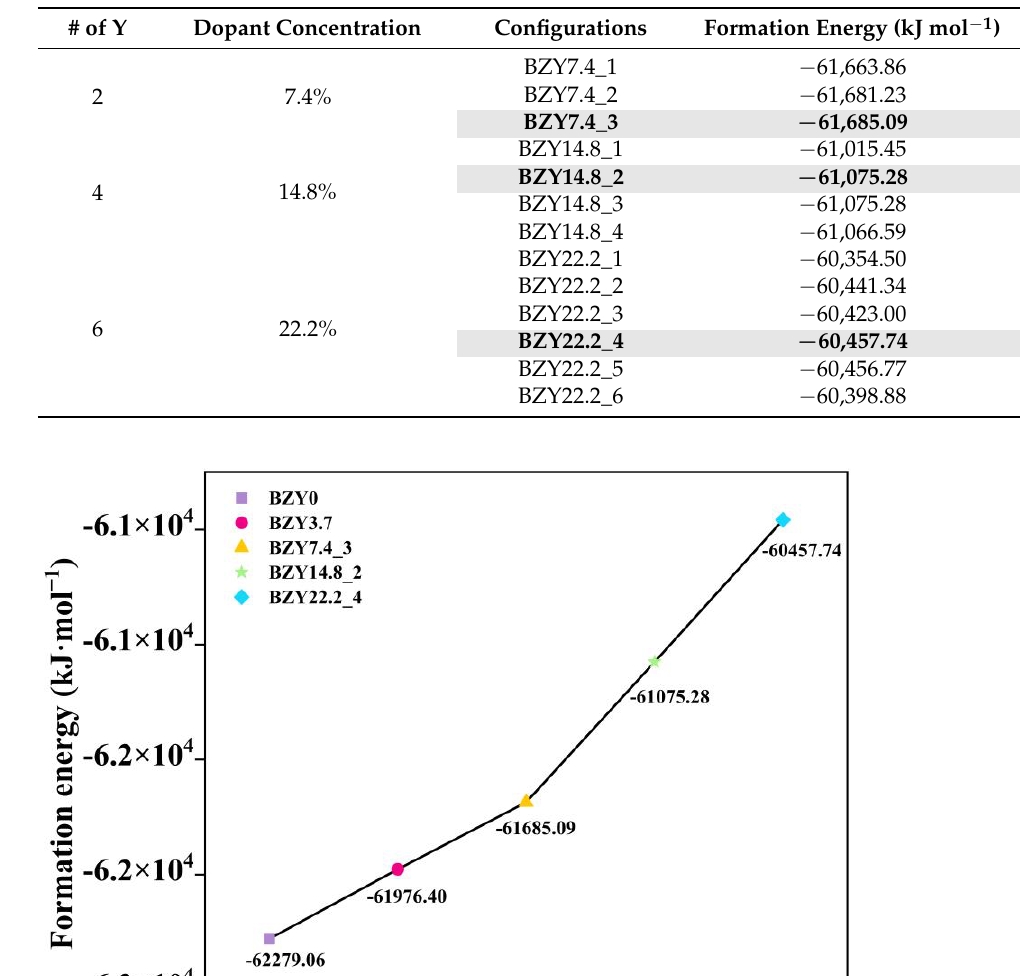
Table 1. Formation energy of BZY structures with different doping contents; the structures screened out by the behaviors marked in gray are used for calculation.